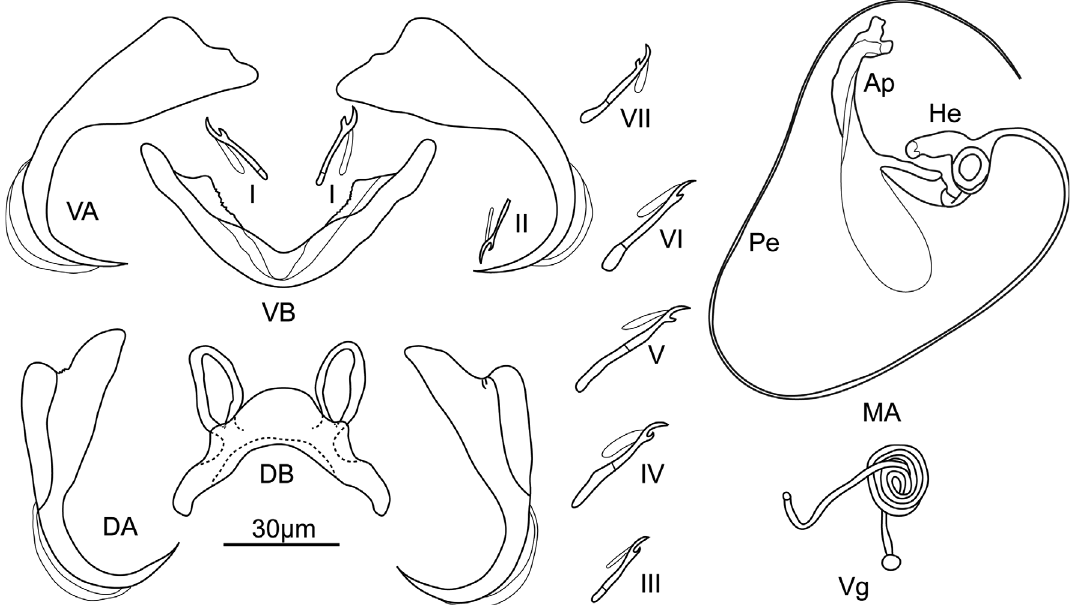
Figure 7. Opisthaptoral and genital sclerotized parts of Cichlidogyrus cirratus Paperna, 1964. Ap, accessory piece; DB, dorsal bar; DA, dorsal anchor; He, heel; Pe, penis; VA, ventral anchor; VB, ventral bar; Vg, vagina; I – VII, hooks.